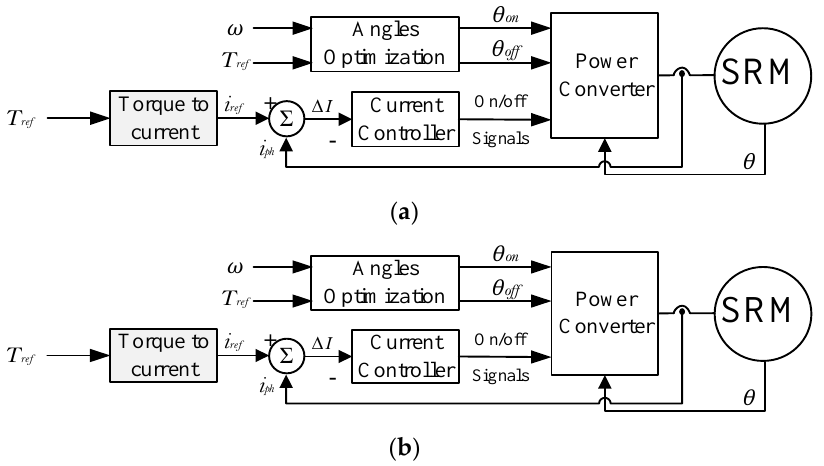
Figure 3. Block diagram of ATC with ( a ) torque controller, and ( b ) torque to current conver- sion.